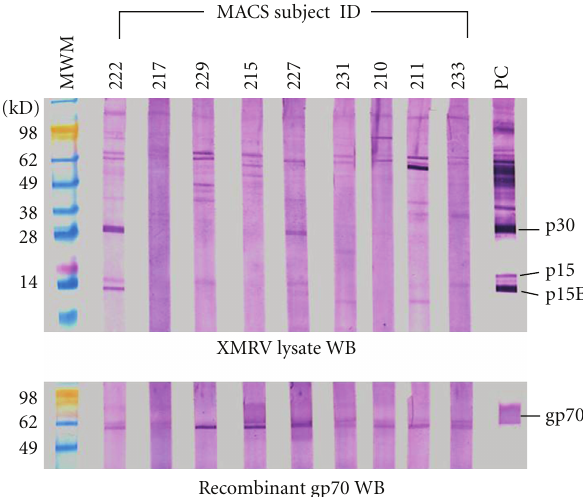
Figure 1: XMRV Western Blot Analysis. WB analysis of CMIA reactive MACS subjects using native XMRV viral lysate and recom- binant gp70 protein. XMRV-infected macaque plasma was used as positive control (PC). Sample 222 tested positive for p15E by CMIA; all the others were positive for gp70 (Table